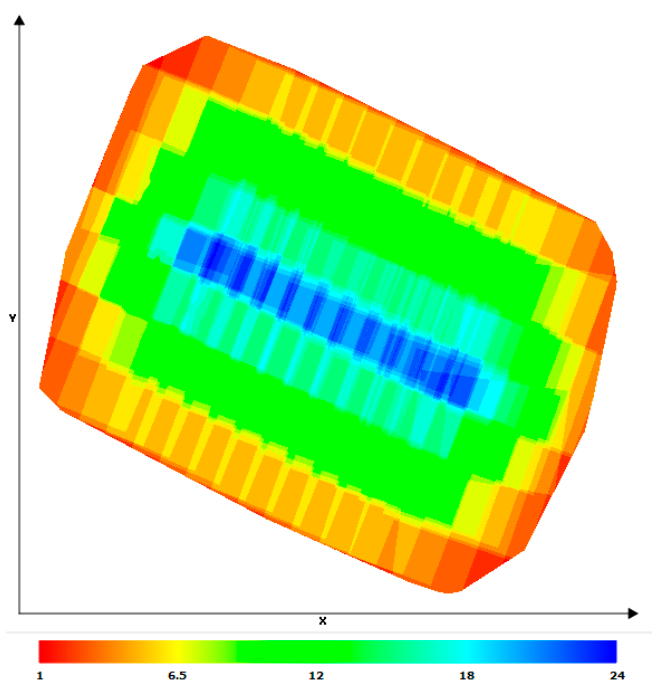
Figure 11. Number of photos covering each area of the pavement, according to color scale.